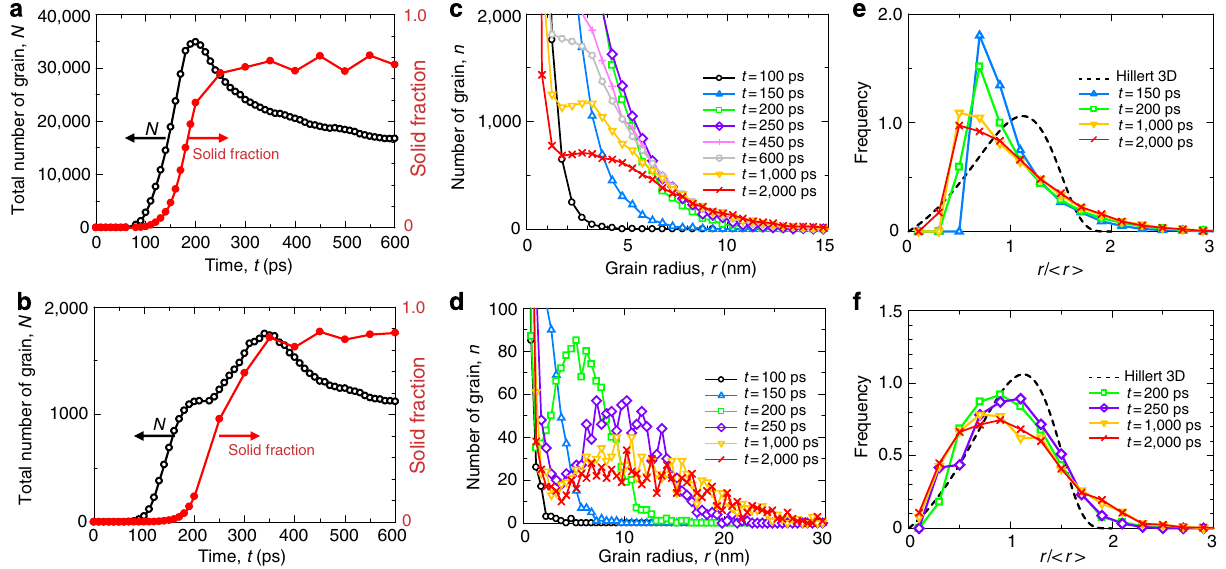
Fig. 3 Transition in the number of grains and the grain size distribution. a , b Time changes of the total number of grains in the simulation cell and the solid fraction for a 0.58 T m and b 0.67 T m . c , d Grain size distribution for several time steps for c 0.58 T m and d 0.67 T m . e , f Grain size distribution normalised by the average grain radius for several time steps for e 0.58 T m and f 0.67 T Figure 3e and f show the grain size distribution normalised by the average grain radius for several time steps. Here, the number of grains with a radius of 2.0 nm or more is counted. In the case of 0.58 T m , the distribution increases with decreasing normalised radius, then suddenly decreases owing to the use of a low-pass fi lter of 2.0 nm, whereas the distribution for 0.67 T m increases and decreases smoothly. Note that the data at the two early time periods represent the distribution of solid grains growing in the liquid, while the data at t = 1,000 and 2,000 ps correspond to the size distribution of grains in the polycrystalline system after the solidi fi cation at both temperatures. Although the grain size distribution at 0.67 T m basically resembles that from derived Hillert ’ s three-dimensional model 39 , it is broader than that derived from the ideal model. This is in agreement with most previous reports 13, 14 since it is known that Hillert ’ s model predicts a narrower distribution owing to the use of mean- fi eld theory.